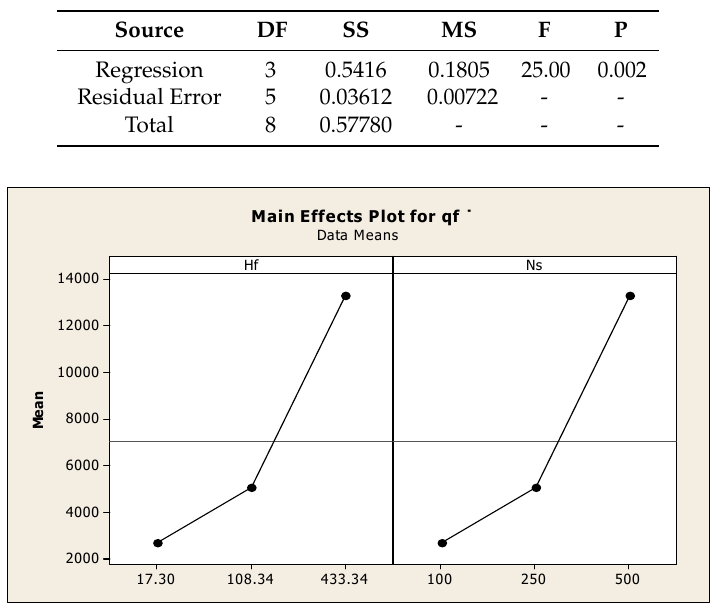
Figure 9. Effect of input heat energy and speed on µ f .